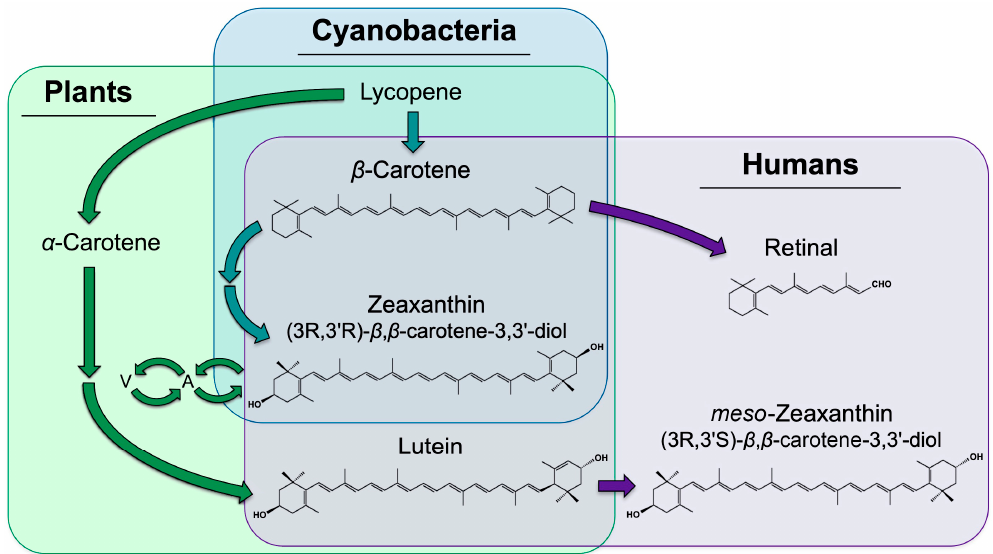
Figure 1. Biosynthetic pathways for the formation of zeaxanthin, lutein, and meso -zeaxanthin. Pathways existing in plants only, area shaded in green only; pathways existing in both plants and cyanobacteria, area shaded in both green and blue; pathways existing in humans, area shaded in purple only; need for dietary acquisition of β -carotene, zeaxanthin, and lutein by humans, overlapping purple and green / blue areas. A, antheraxanthin, a zeaxanthin mono-epoxide; V, violaxanthin, a zeaxanthin di-epoxide.